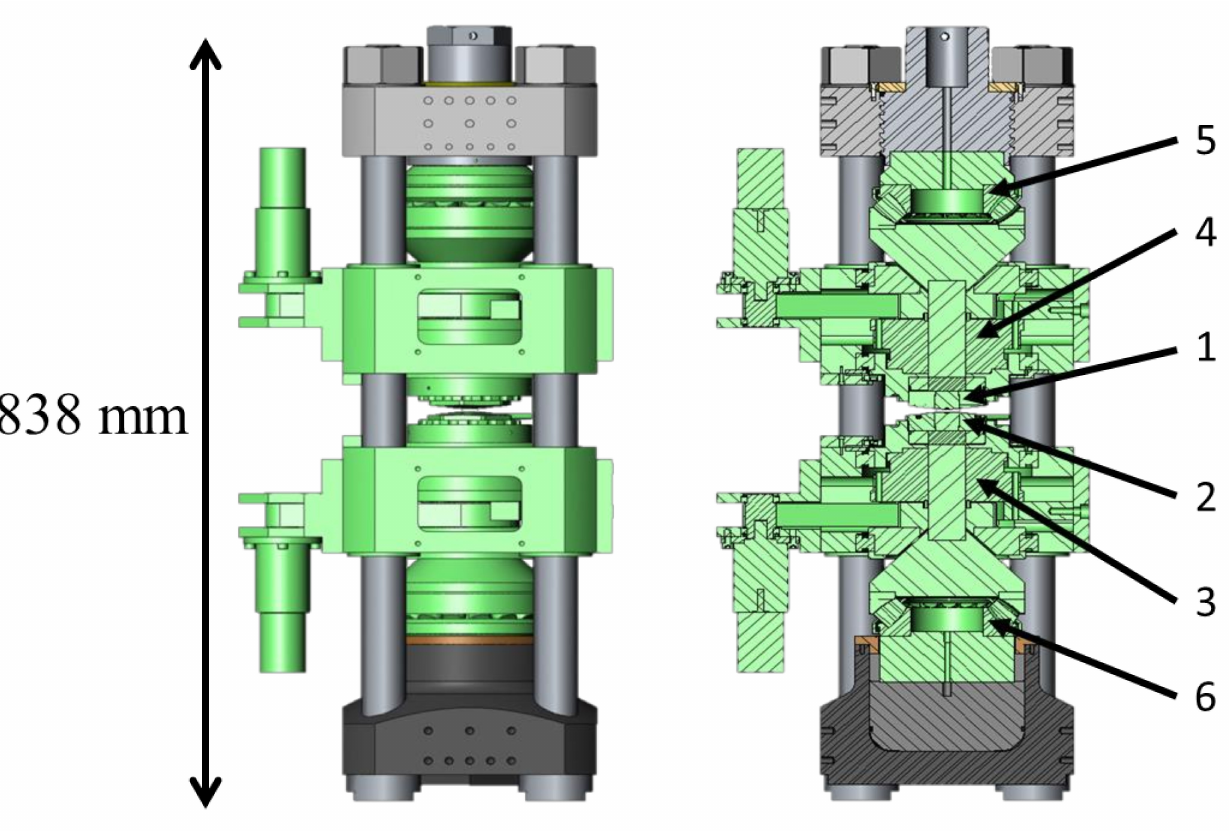
Figure 21. 3D scheme and cross-section of the RoToPEc module which can be installed on HP-SPS device [52]: (1) rotating upper anvil, (2) rotating lower anvil, (3) lower gear reducer, (4) upper gear reducer, (5) upper thrust bearings, (6) lower thrust